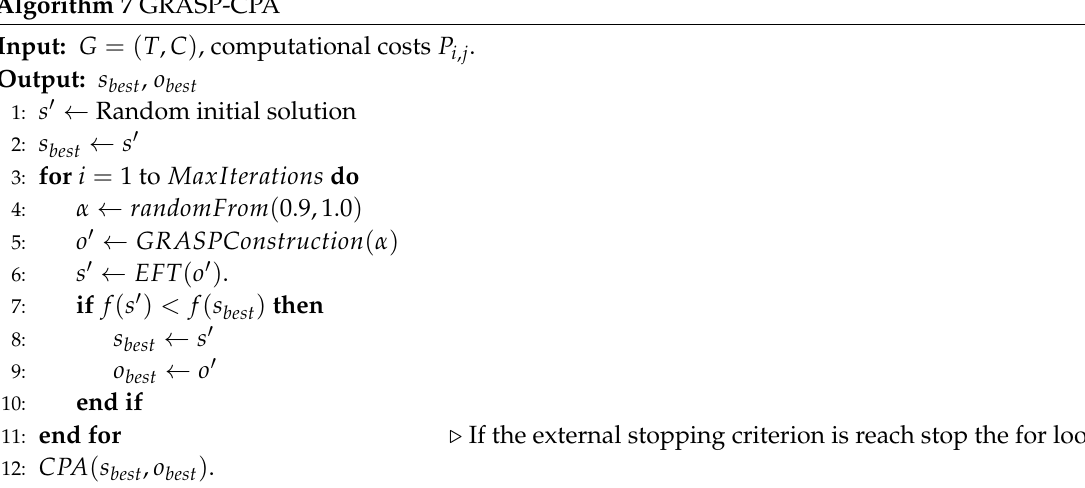
Figure 2. Proposed Greedy Randomized Adaptive Search Procedure (GRASP)-Cellular Processing Algorithm (CPA) flow chart diagram. Algorithm 7 GRASP-CPA